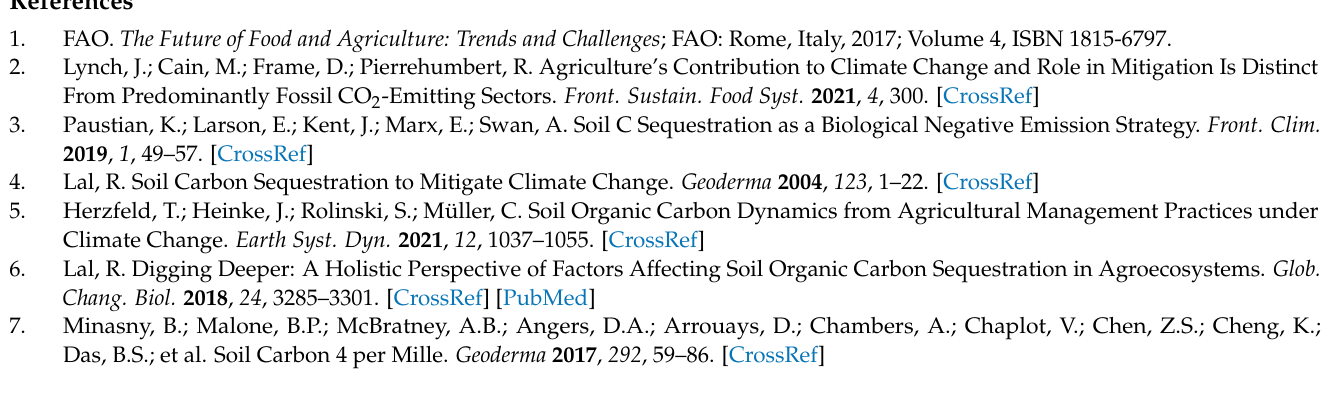
results. Table S3: Overview of the studies in the nitrogen dataset and their treatments and results. Table S4: Overview of the results of the random effects model for soil carbon stock and their statistics. From column L onwards, measures of heterogeneity of the random effects model are presented, once for the entire data set and once for within groups. Table S5: Overview of the results of the random effects model for soil nitrogen stock and their statistics. From column L onwards, measures of heterogeneity of the random effects model are presented, once for the entire data set and once for within